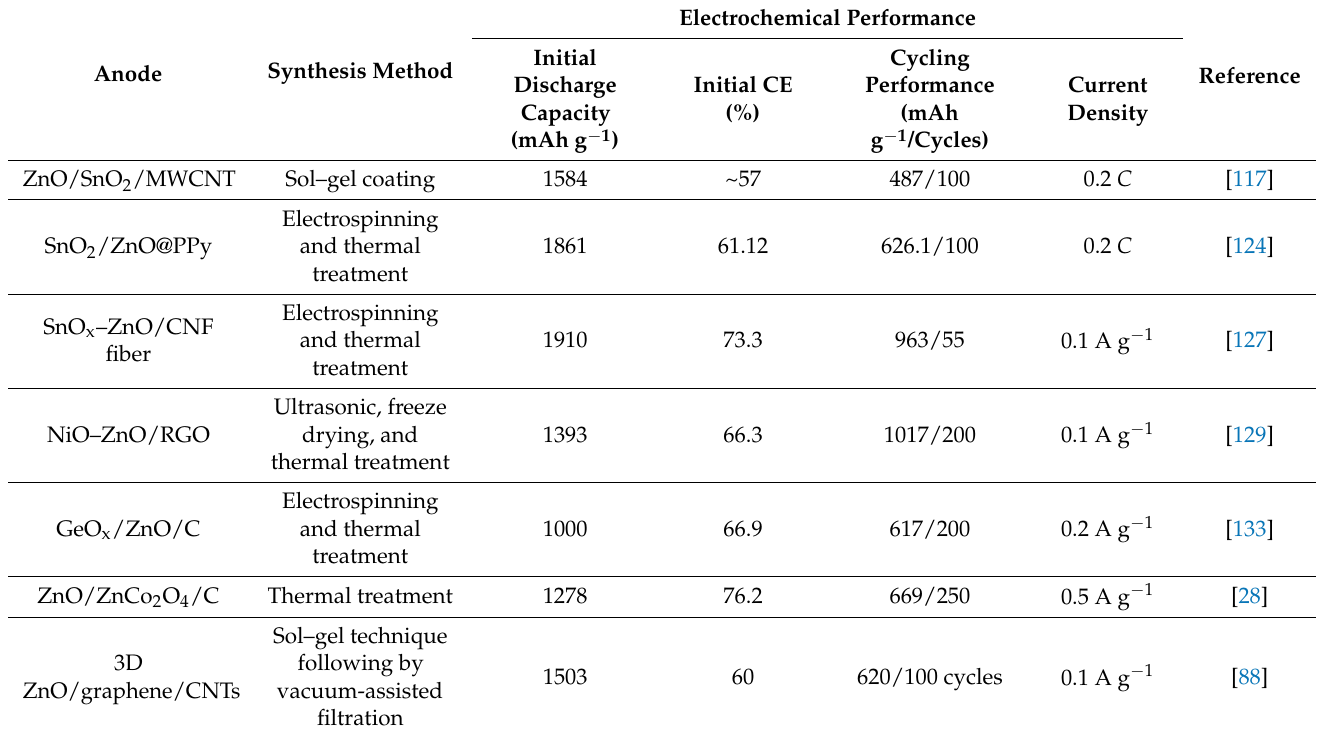
Table 3. Summary of highlighted ZnO ternary composite